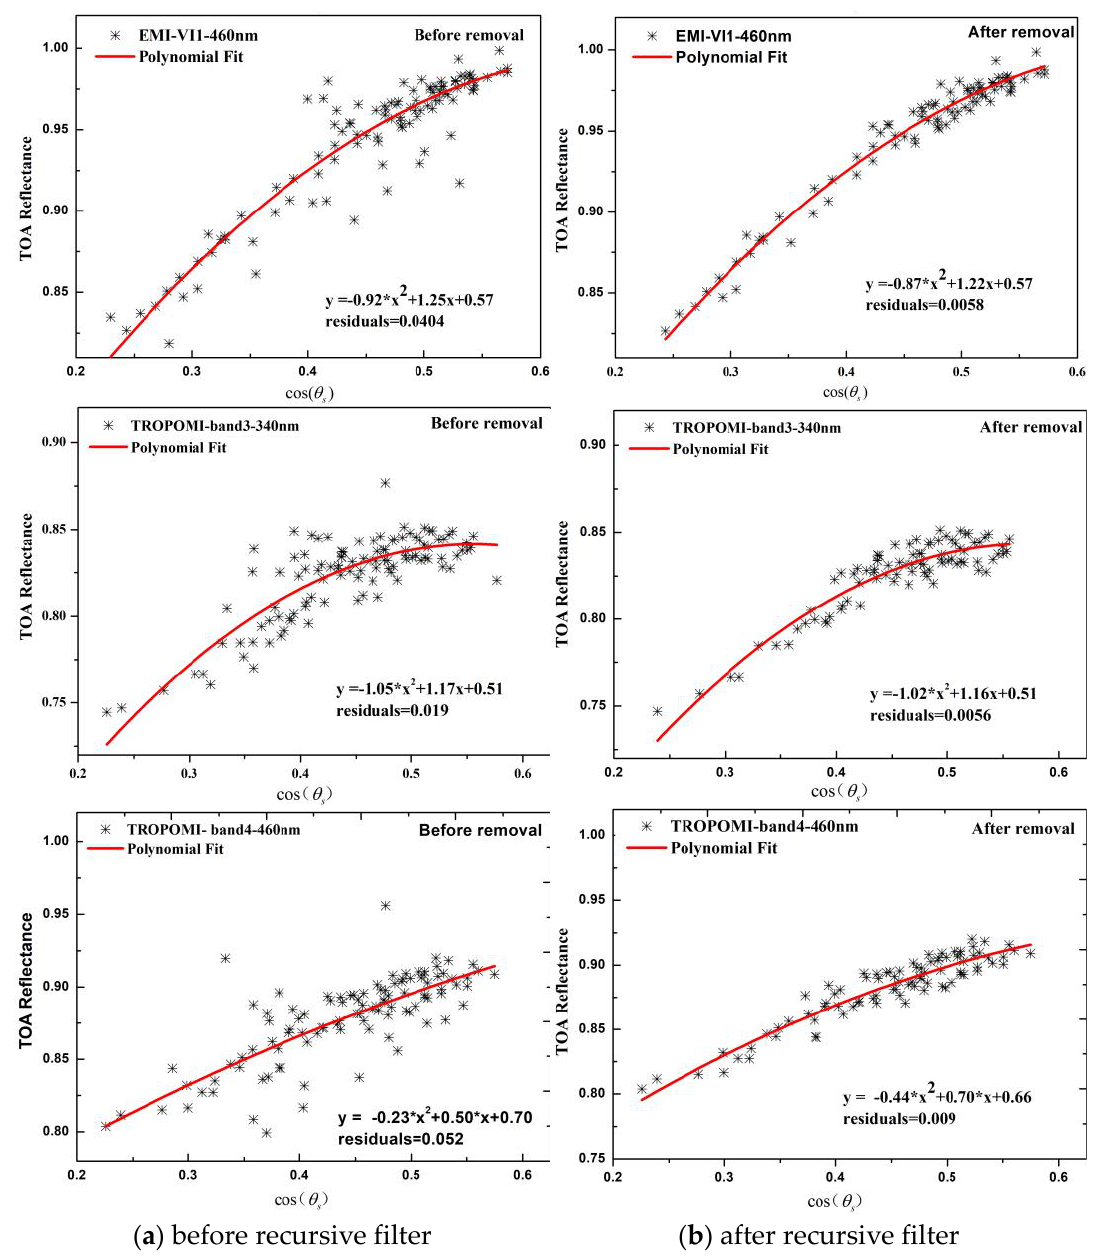
Figure 5. Polynomial relationship between the reflectance factor and SZA for EMI-2/TROPOMI data.